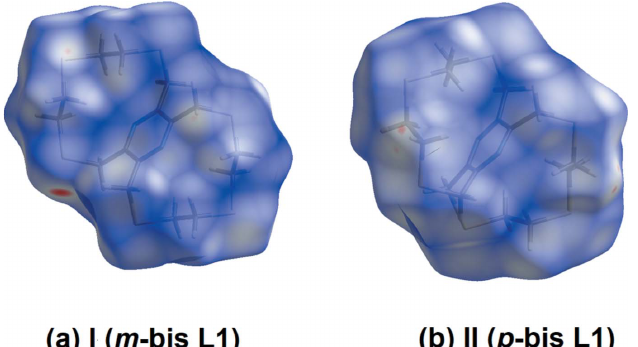
Figure 5 ( a ) The Hirshfeld surface of I , mapped over d norm in the colour range (cid:4) 0.1136 to 1.0310 a.u., ( b ) the Hirshfeld surface of II , mapped over d in the colour range (cid:4) 0.0862 to 1.1988